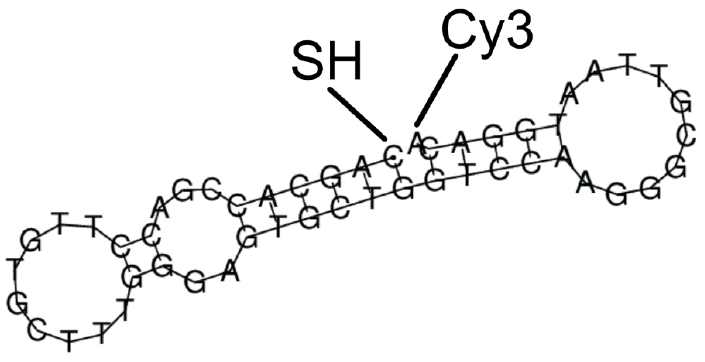
Figure 1. The SH-RBD-1C-Cy3 aptamer structure.